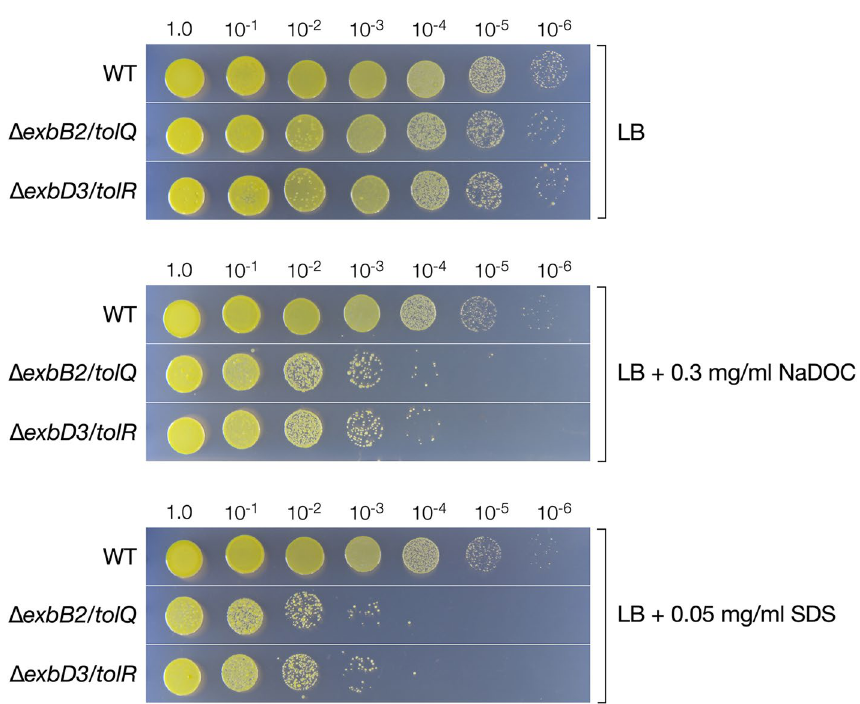
Figure 5. ∆ exbB2 / tolQ and ∆ exbD3 / tolR cells show susceptibility to detergents. The cells of SYK-6, ∆ exbB2 / tolQ , and ∆ exbD3 / tolR were grown in LB with or without 0.3 mg ml −1 of NaDOC or 0.05 mg ml −1 SDS. The cell diluted with Wx buffer (10 µl) were dropped onto LB agar medium and incubated at 30 °C for 72 h. This figure was generated using Canvas X Draw version 7.0.2. (https:// www. canva sgfx. com/ produ cts/ canvas- x-